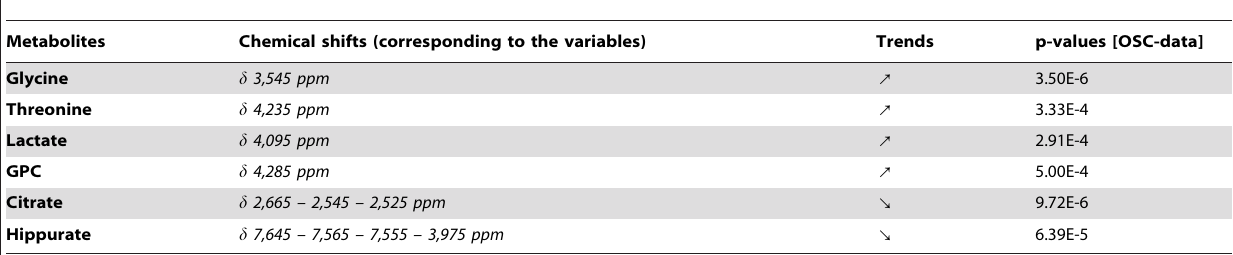
Abbreviation: GPC: glycerophosphocholine. The trends are observed after an OSC filtering. The significance was assessed with a non-parametric Kruskal-Wallis test (threshold